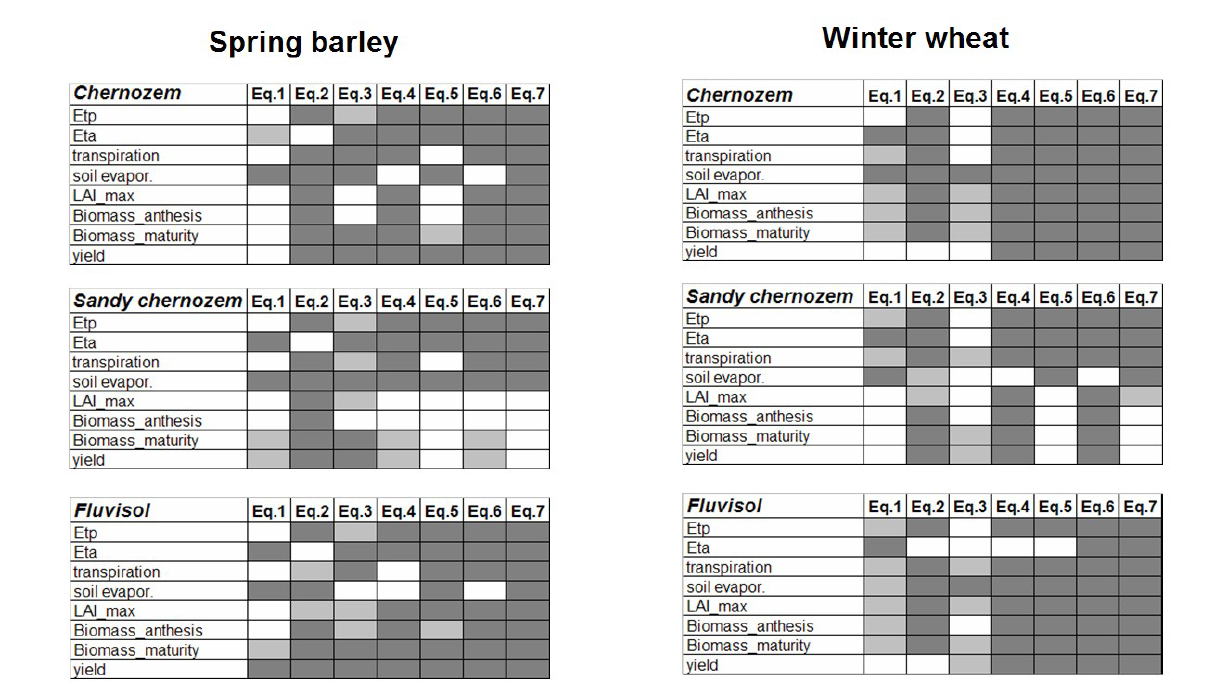
Figure 2. Visualization of the statistical significant differences between the crop model runs (CERES- Barley & CERES-Wheat), using the observed R data (control) and the daily R estimates based on G G Eqs. (1)-(7). The white color represents those runs where no statistically significant difference was found; gray color stands for the statistically significant difference at the 5 % level of significance whilst the black color represents the significant difference at 1 % level. The differences were tested by paired t-test, if the distribution was found to be normal (assessed by one sample Kolmogorov-Smirnov test at Lilliefors 5 % significance level) and for non-normally distributed samples by Wilcoxon Signed Rank